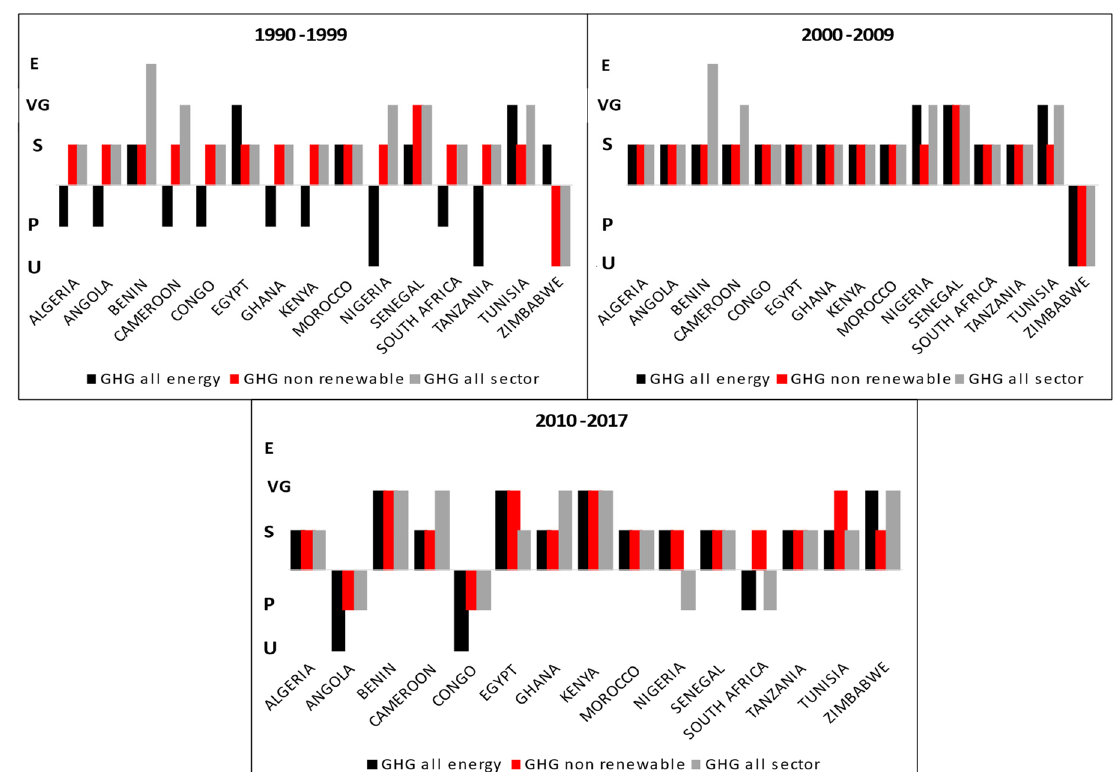
Energies 2021 , 14 , x FOR PEER REVIEW Figure 5. EWF’s GHG footprint-Food GHG footprint (source calculated by equation 7). Figure 5. EWF’s GHG footprint—food GHG footprint.